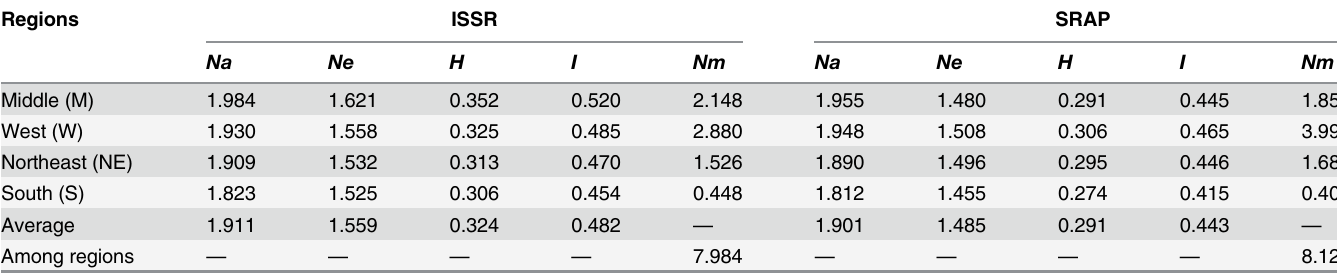
Table 5. Parameters related to the genetic diversity and gene flow of Blumeria graminis f. sp. tritici in Sichuan, China.